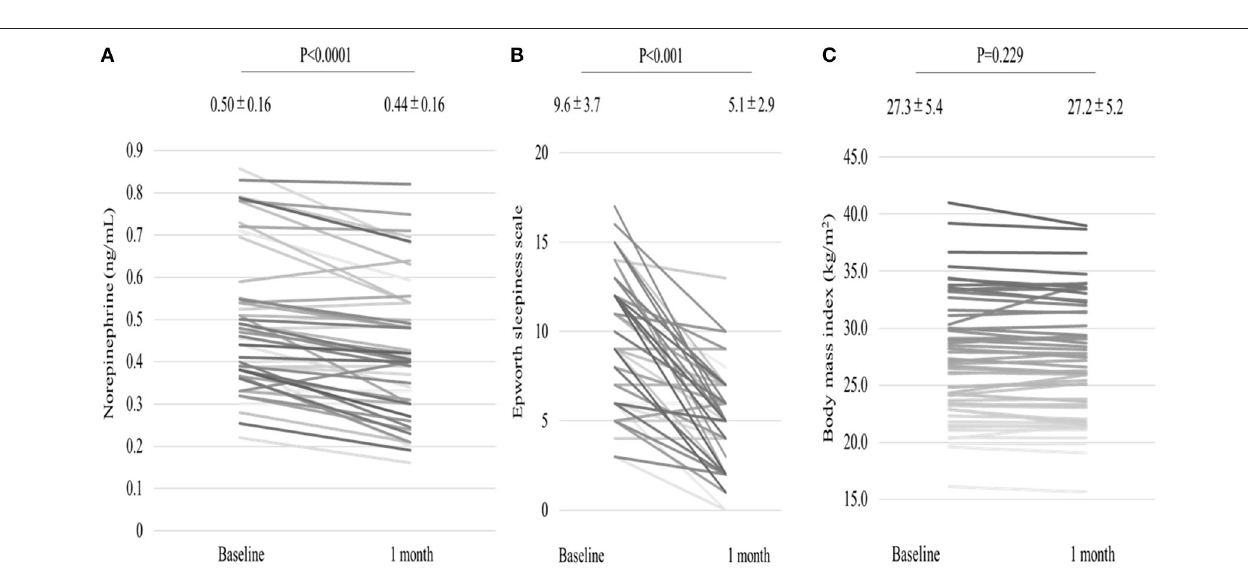
FIGURE 3 | Serum norepinephrine concentration levels (A) decreased, and Epworth Sleepiness Scale (B) improved after 1 month of CPAP treatment, while no significant change in BMI (C) was